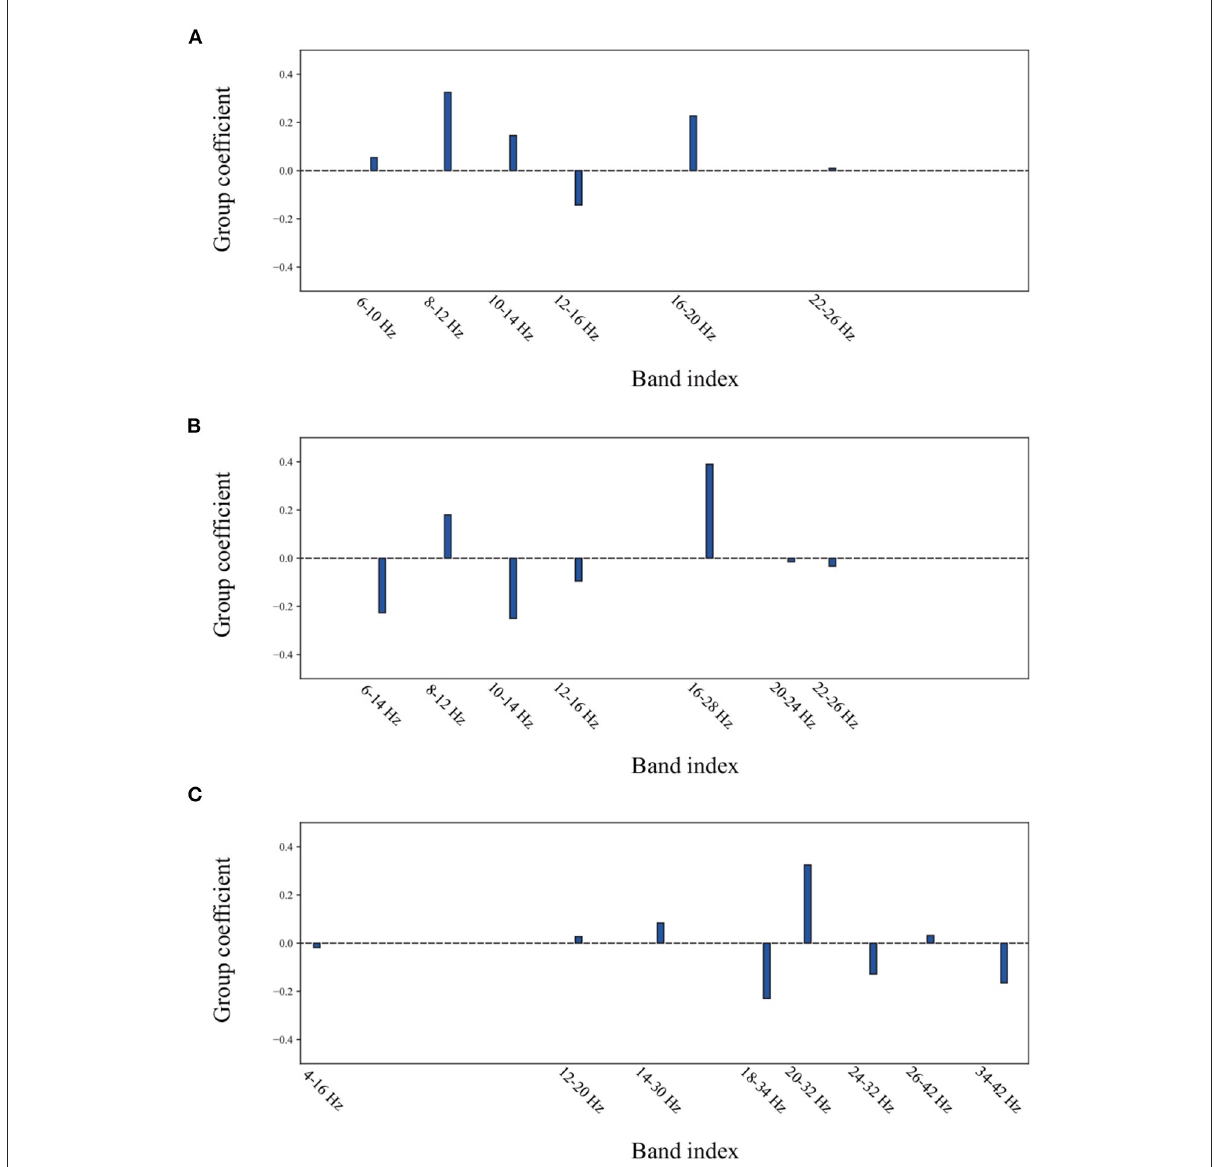
FIGURE8 The group coefficient distribution learned by the proposed method from a typical subject. (A) the subject A09 from in-house dataset without stimulation. (B) the subject A09 from in-house dataset with stimulation. (C) the subject S07 from BCI competition dataset IIa.